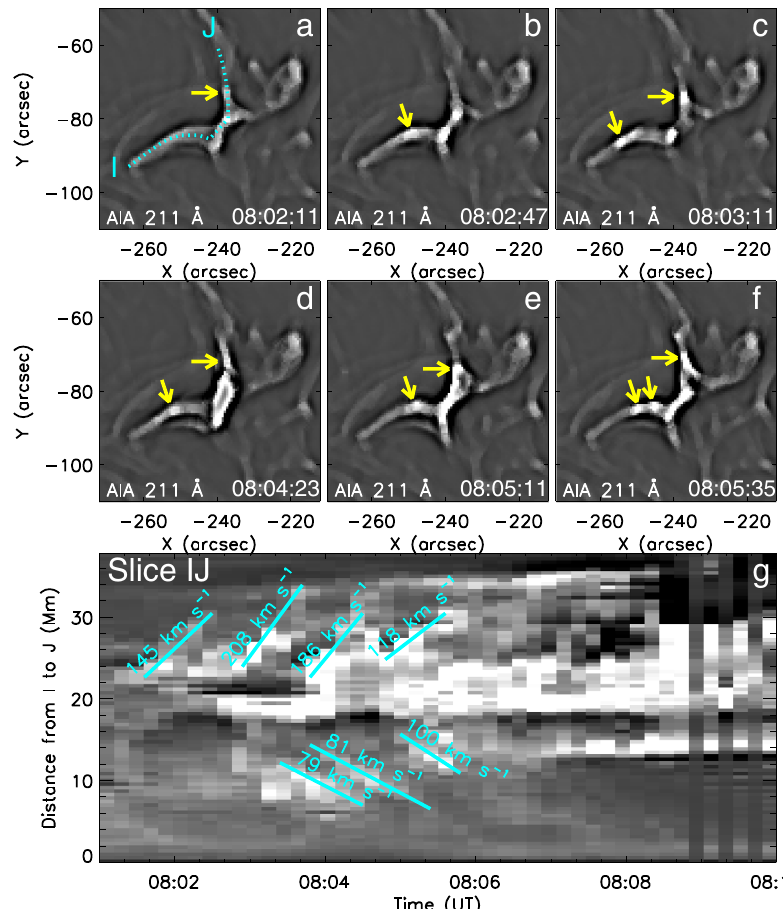
Fig. 5 Plasmoids in the SDO/AIA 211 Å images revealed by the unsharp masking technique. Yellow arrows mark the different bright blobs moving from the reconnection region ( a – f ). The cyan-dotted line in a indicates the trajectory I-J used to make the time-distance diagram of g . The projected velocities of the blobs lie in the range from 79 km s − 1 to 208 km s − 1 . Note that the y -axis denotes the direction information in the time-distance maps of g . Source data are provided as a Source Data fi